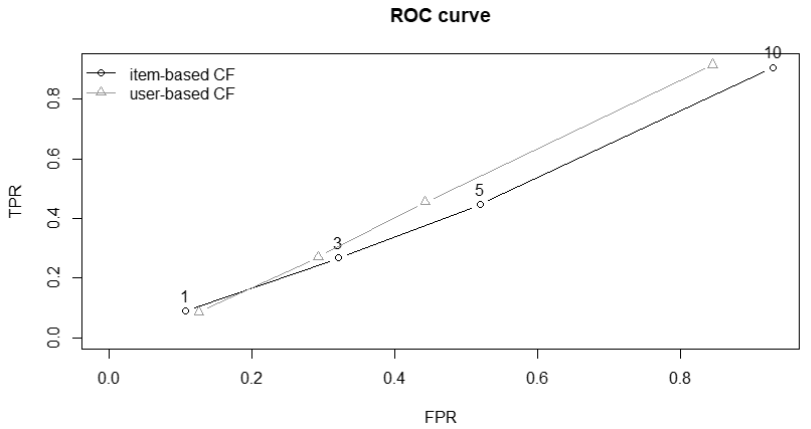
Figure 2. ROC curve, a possible way to compare the efficiency of two systems by comparing the size of the area under the curve, where a larger area indicates better performance. The default plot of the ROC curve plots the true positive rate (TPR) against the false positive rate (FPR).